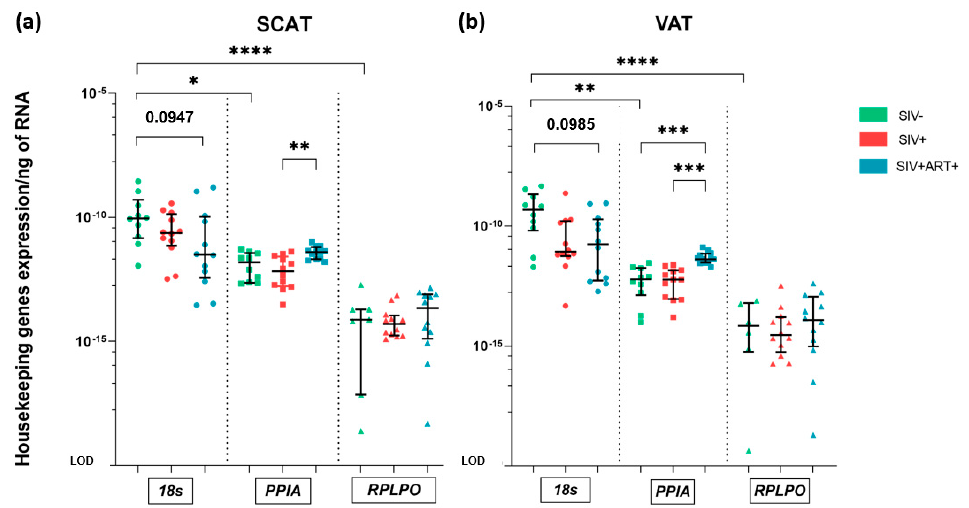
Figure 1. Housekeeping gene selection. Real-time quantitative PCR (RT-qPCR) analysis of the RNA expression of three housekeeping genes ( 18S , PPIA , and RPLPO ). The level of gene expression was normalized against the total amount of RNA extracted from each sample. The limit of detection (LOD) corresponds to the difference after 50 cycles, i.e., a minimum detectable ratio of 10 − 20 after normalization against the total amount of RNA ( a , b ) RNA expression of 18S , PPIA and RPLPO housekeeping genes within SCAT ( a ) and VAT ( b ) in the SIV − (green) ( 18s and PPIA n = 10, RPLPO n = 7 ), SIV+ (red) ( n = 12) and SIV+ART+ (blue) ( n = 12) groups. The results are quoted as the median [IQR]. Kruskal–Wallis tests associated with Dunn’s multiple comparison test or Mann– Whitney tests were used for unpaired and paired comparisons, respectively. Only statistically significant results are shown: * p < 0.05, ** p < 0.005, *** p < 0.001, **** p <